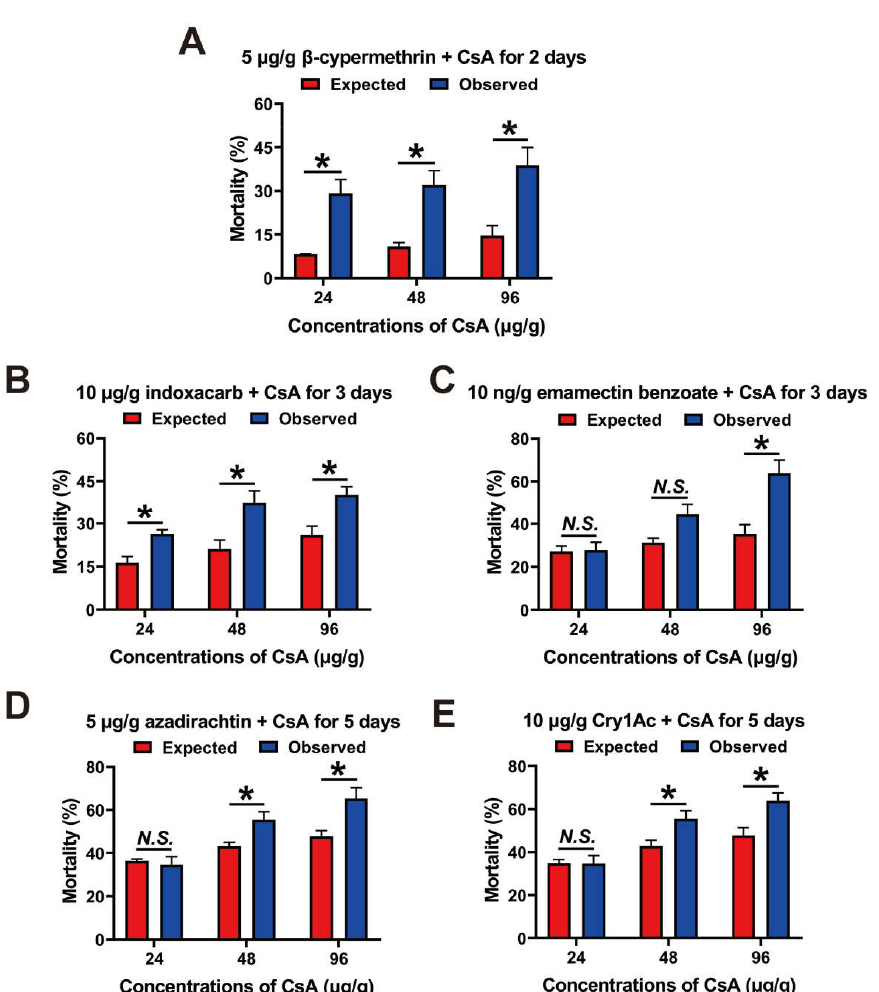
Figure 4. Combined toxicity of CsA and five toxins against 3rd-instar larvae of O. furnacalis . ( A ) Significant synergistic effects of the combinations of 5 μg/g of β-cypermethrin + 24/48/96 μg/g of CsA against 3rd-instar larvae for 2 days. ( B ) Significant synergistic combined toxicities of 10 μg/g of indoxacarb + 24/48/96 μg/g of CsA against 3rd-instar larvae for 3 days. ( C ) Expected and observed mortality under the combinations of 10 ng/g of emamectin benzoate + 24/48/96 μg/g of CsA for 3 days. ( D ) Expected and observed mortality caused by the combinations of 5 μg/g of azadirachtin + 24/48/96 μg/g of CsA against 3rd-instar larvae for 5 days. ( E ) Expected and observed mortality of larvae fed 10 μg/g of Cry1Ac + 24/48/96 μg/g of CsA for 5 days. Data are shown as means ± SE of three biological replicates, and the significant differences were analyzed using independent samples t -test on SPSS Statistics 20; “ * ” indicates p < 0.05, “ N.S. ” indicates no significant difference. 4. Discussion Because CsA is a product of fungal metabolism, in this study, its insecticide activity was compared with that of Bt toxins, which are the most widely used biogenic insecticides in the world for controlling lepidopteran pests, including O. furnacalis . Bioassays of labor- atory-raised neonatal larvae of O. furnacalis revealed that the respective LC 50 values of Cry1Aa, Cry1Ab, Cry1Ac, and Cry1F were 0.18 (0.15–0.22), 0.28 (0.2–0.36), 0.26 (0.19–0.34), and 0.52 (0.36–0.70) μg/g after 7 days of exposure [34]. Regarding Vip toxins, Vip3Ca is the most toxic protein (LC 50 = 1.2 μg/g), followed by Vip3_ch2 (LC 50 = 2.3 μg/g) and